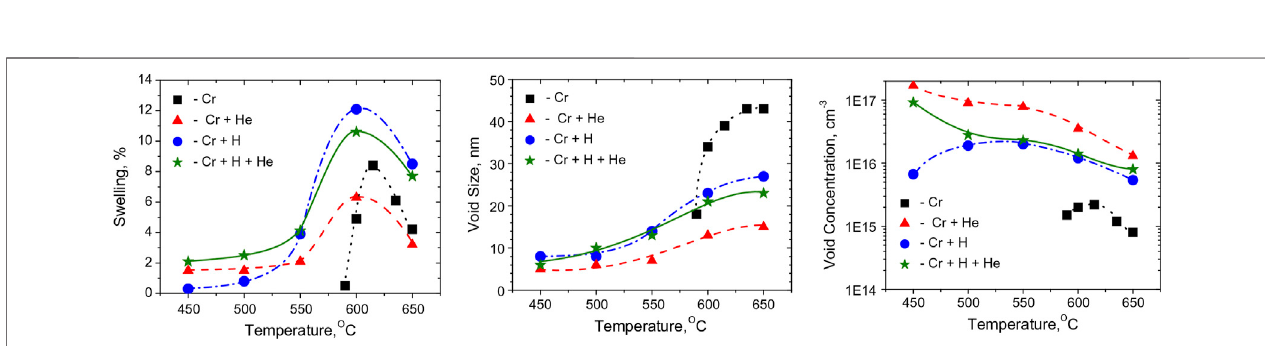
FIGURE 5 | The dependence of synergistic effects on temperature in AUSS. The peak swelling temperature has a slight shift under single and multi-beam irradiation. And at the peak swelling temperature, the (HI + H) dual beam irradiation causes the maximum swelling (Borodin et al., 2013).